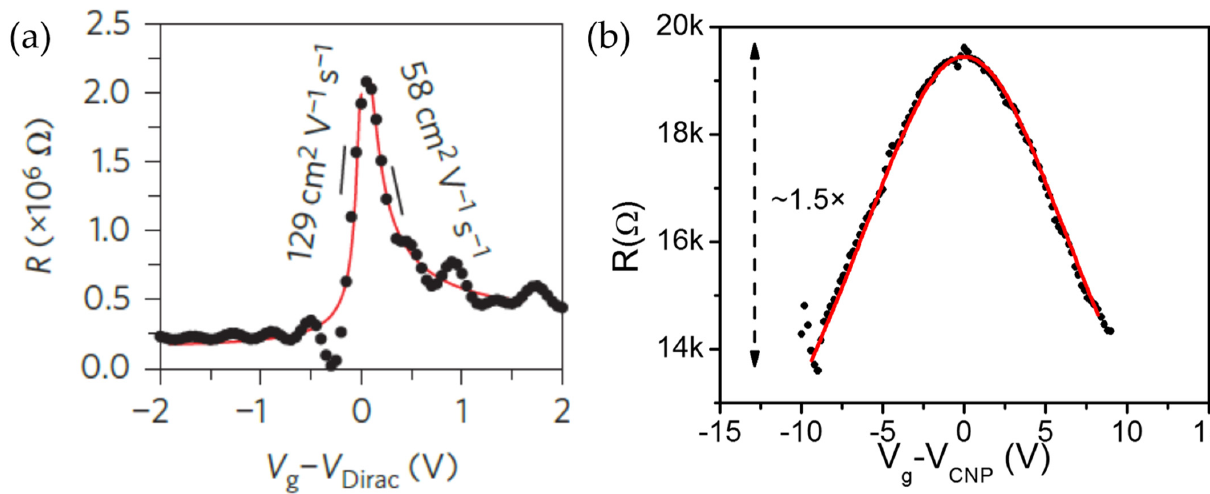
Figure 2. Resistance versus voltage overdrive measured transfer characteristics of single- and multi-layer silicene FETs. ( a ) By means of ambipolar diffusive transport model typically used for graphene FETs, extracted low-field hole and electron carrier mobilities of 129 and 99 cm 2 · V − 1 · s − 1 in single-layer silicene device. Adapted with permission from Ref. [34]. ( b ) As for ( a ), 66–200 cm 2 · V − 1 · s − 1 for 24 monolayers thick FET. Adapted with permission from Ref. [35].